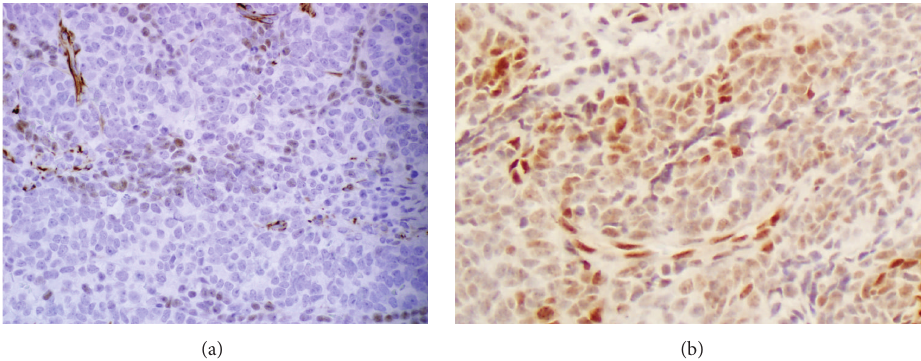
Figure 6: (a) Small cell component weakly and focally reactive for WT1, immunohistochemistry × 400. (b) Antibodies against FLI1 decorated a component of the small cell population, immunohistochemistry × 200.